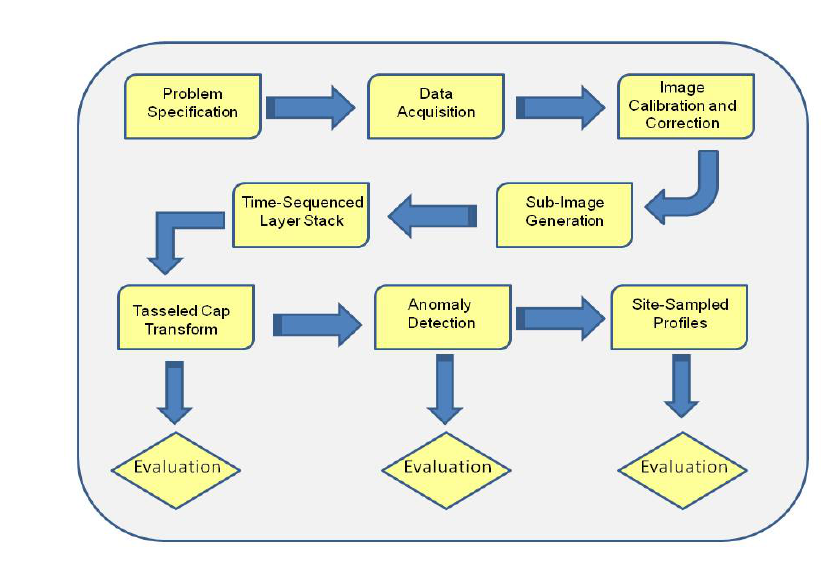
Figure 2. General methodology used in the analysis.